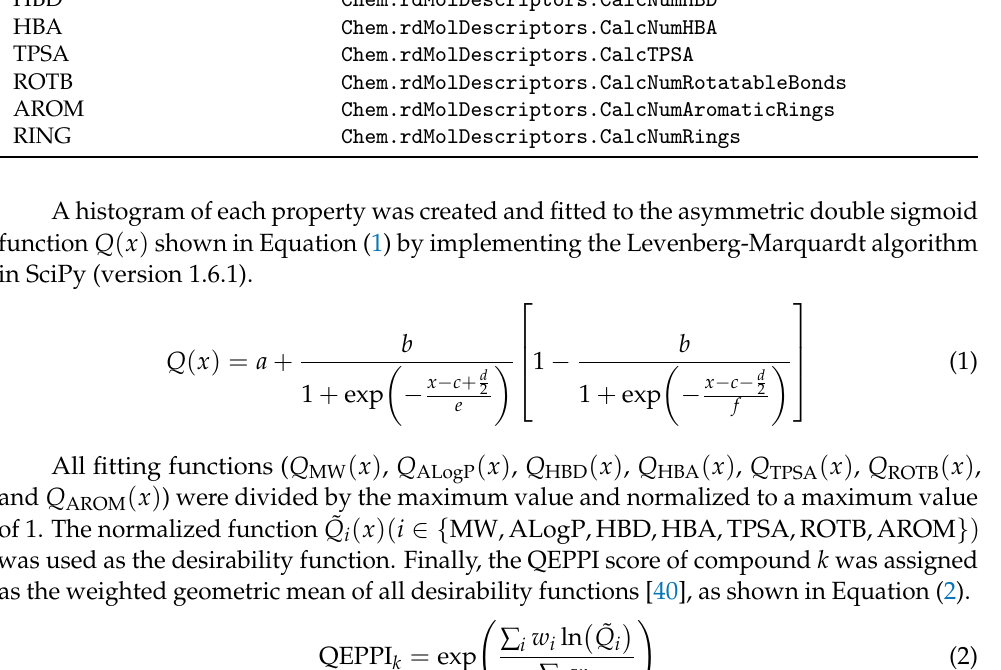
Table 5. RDKit functions used to calculate the molecular properties used in quantitative estimate of protein-protein interaction targeting drug-likeness (QEPPI) and rule-of-four (RO4). Property RDKit Function MW Chem.rdMolDescriptors.CalcExactMolWt ALogP Chem.Crippen.MolLogP HBD Chem.rdMolDescriptors.CalcNumHBD HBA Chem.rdMolDescriptors.CalcNumHBA TPSA Chem.rdMolDescriptors.CalcTPSA ROTB Chem.rdMolDescriptors.CalcNumRotatableBonds AROM Chem.rdMolDescriptors.CalcNumAromaticRings RING